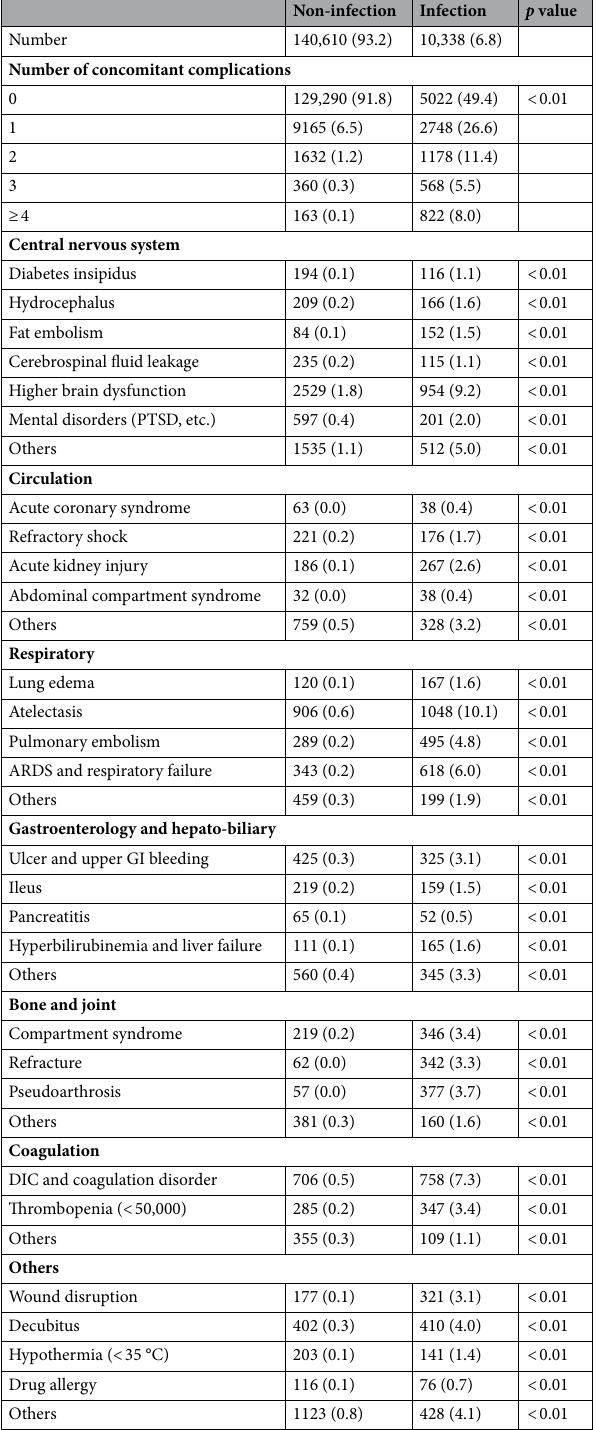
Table 2. Concomitant complications in patients with and without infection. PTSD post trauma stress disorder, ARDS acute respiratory destress syndrome, GI gastrointestinal, DIC disseminated intravascular